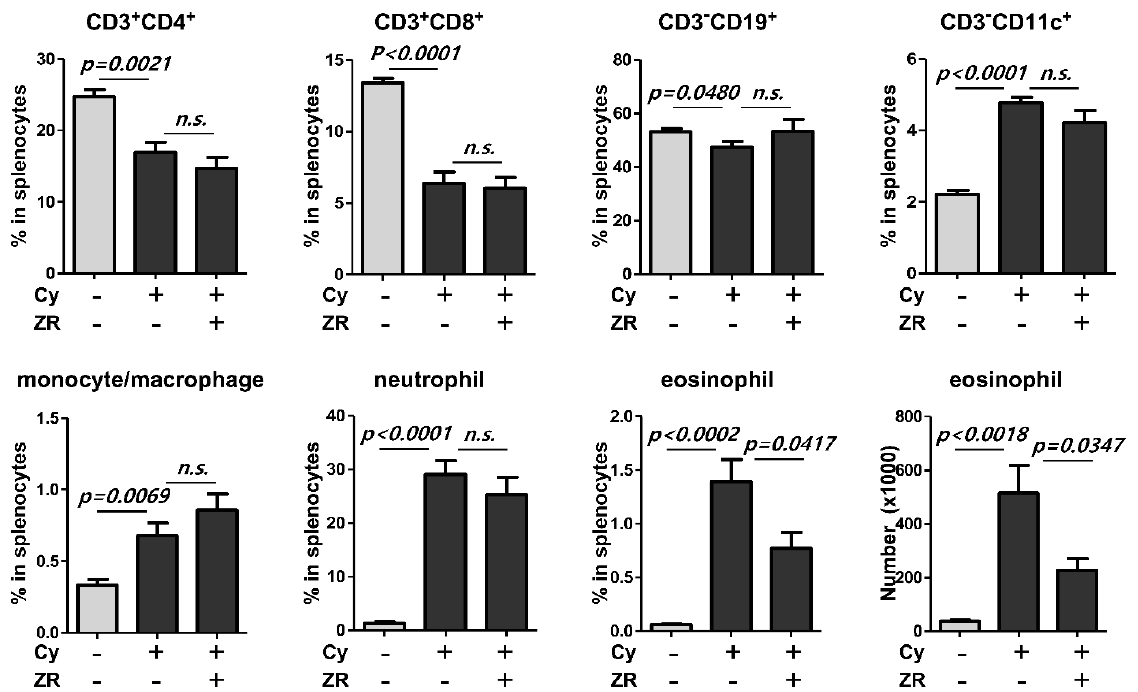
Figure 4. Analysis of immune cell composition in the splenocytes of ZR-administered immunosuppressed mice before flu vaccination. At the time of completion of ZR administration and after Cy injection, compositions of seven different types of immune cells were assessed in the isolated splenocytes from mice using flow cytometric analysis ( n = 5, each group). Cy, cyclophosphamide; ZR, Zingiberis Processum Rhizoma . Statistical analysis was performed using Student’s t -test.